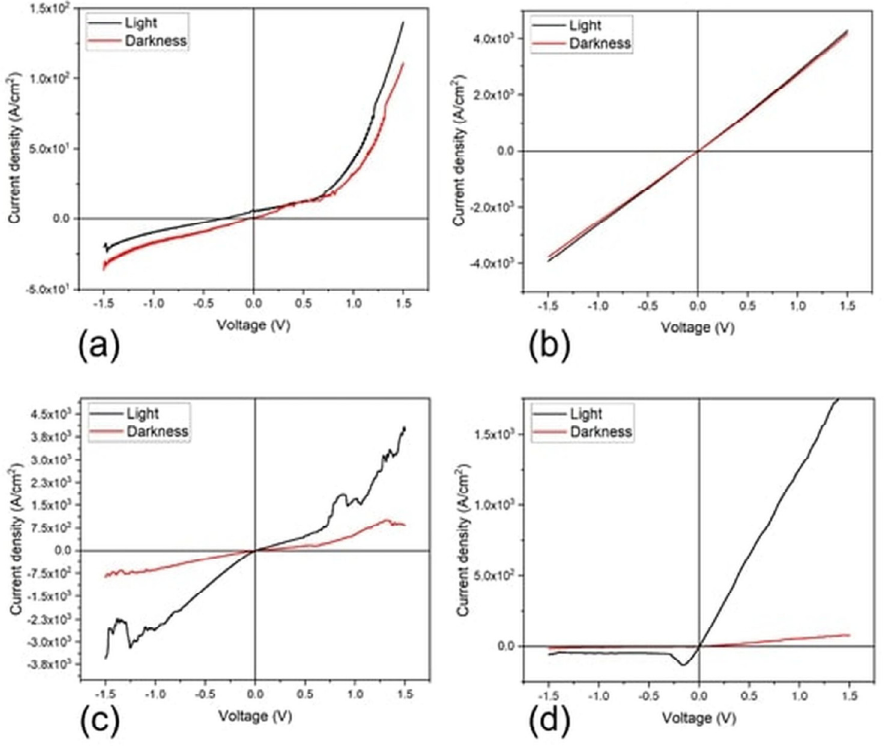
Figure 10. Darkness and illuminated J–V characteristic curve plot of ( a ) TiCl 2 Pc and ( b ) TiOPc and ( c , d ) with PEDOT:PSS devices, respectively.